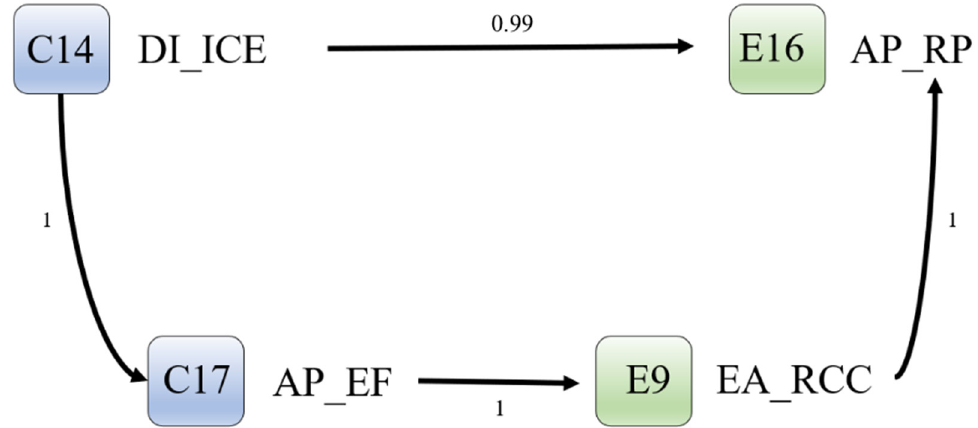
Figure 2. Incidence between information dissemination and learning C 14 → E 16 . Source: Own elaboration. C 14 DI_ICE: The information provided by the company is clear and understandable; C